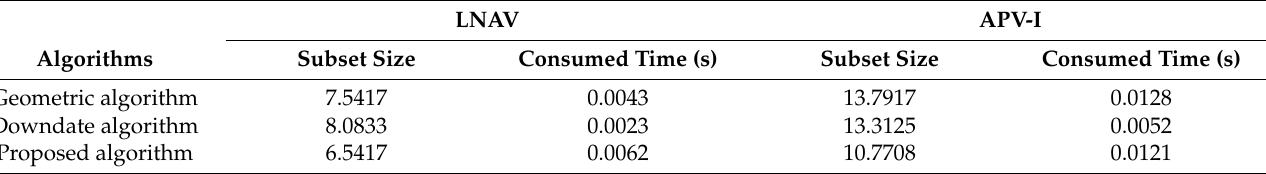
Figure 8. 2drms, HPL and subset size of the final subset constructed by each algorithm under APV-I horizontal requirement. ( a ) 2drms value; ( b ) HPL value; ( c ) Subset size. Table 5. Average subset size and consumed time of each algorithm in the minimal subset size trial.